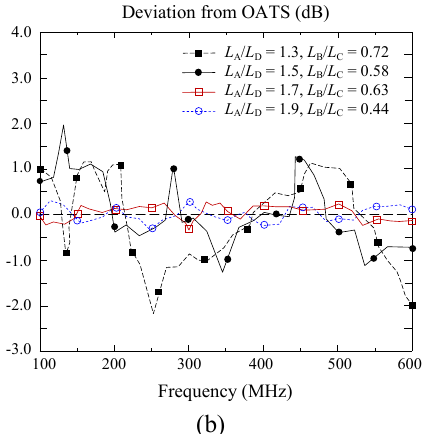
Figure 21: (a) Field uniformity and (b) efficiency optimiza- tion of the double horn semi-anechoic chamber.